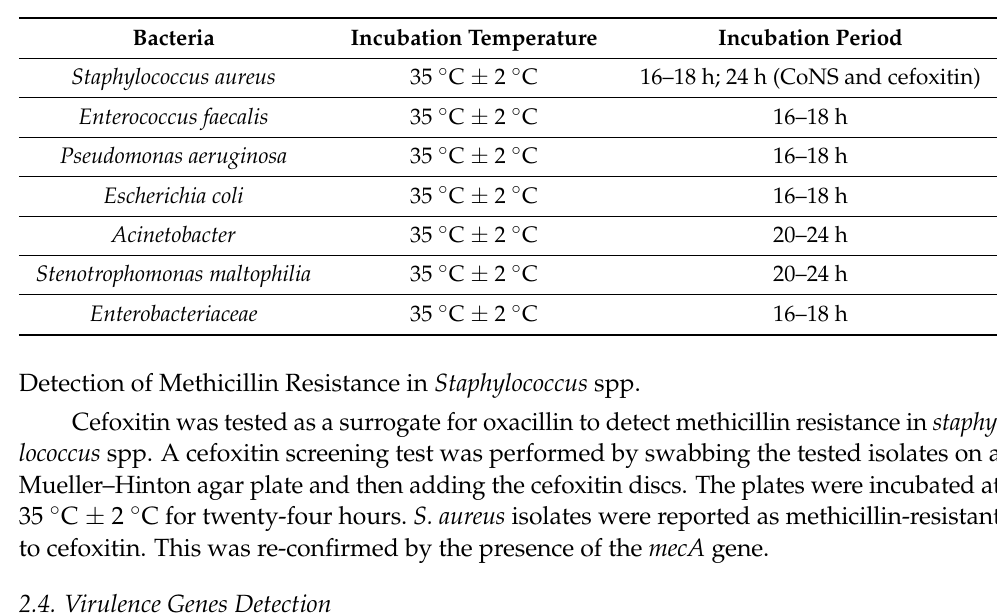
Table 1. Incubation conditions of bacterial